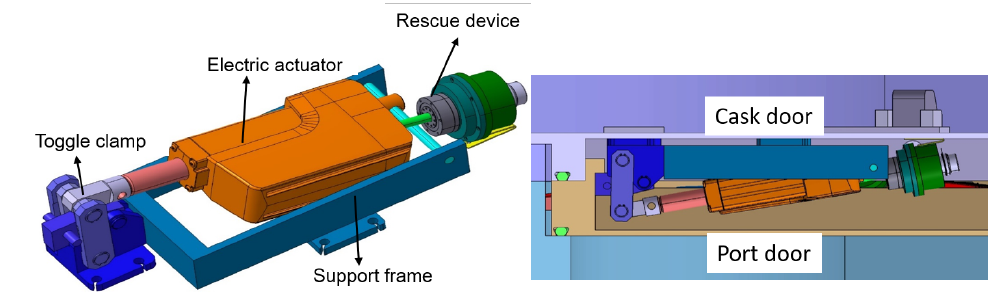
Figure 7. The locking mechanism between the cask door and port door.